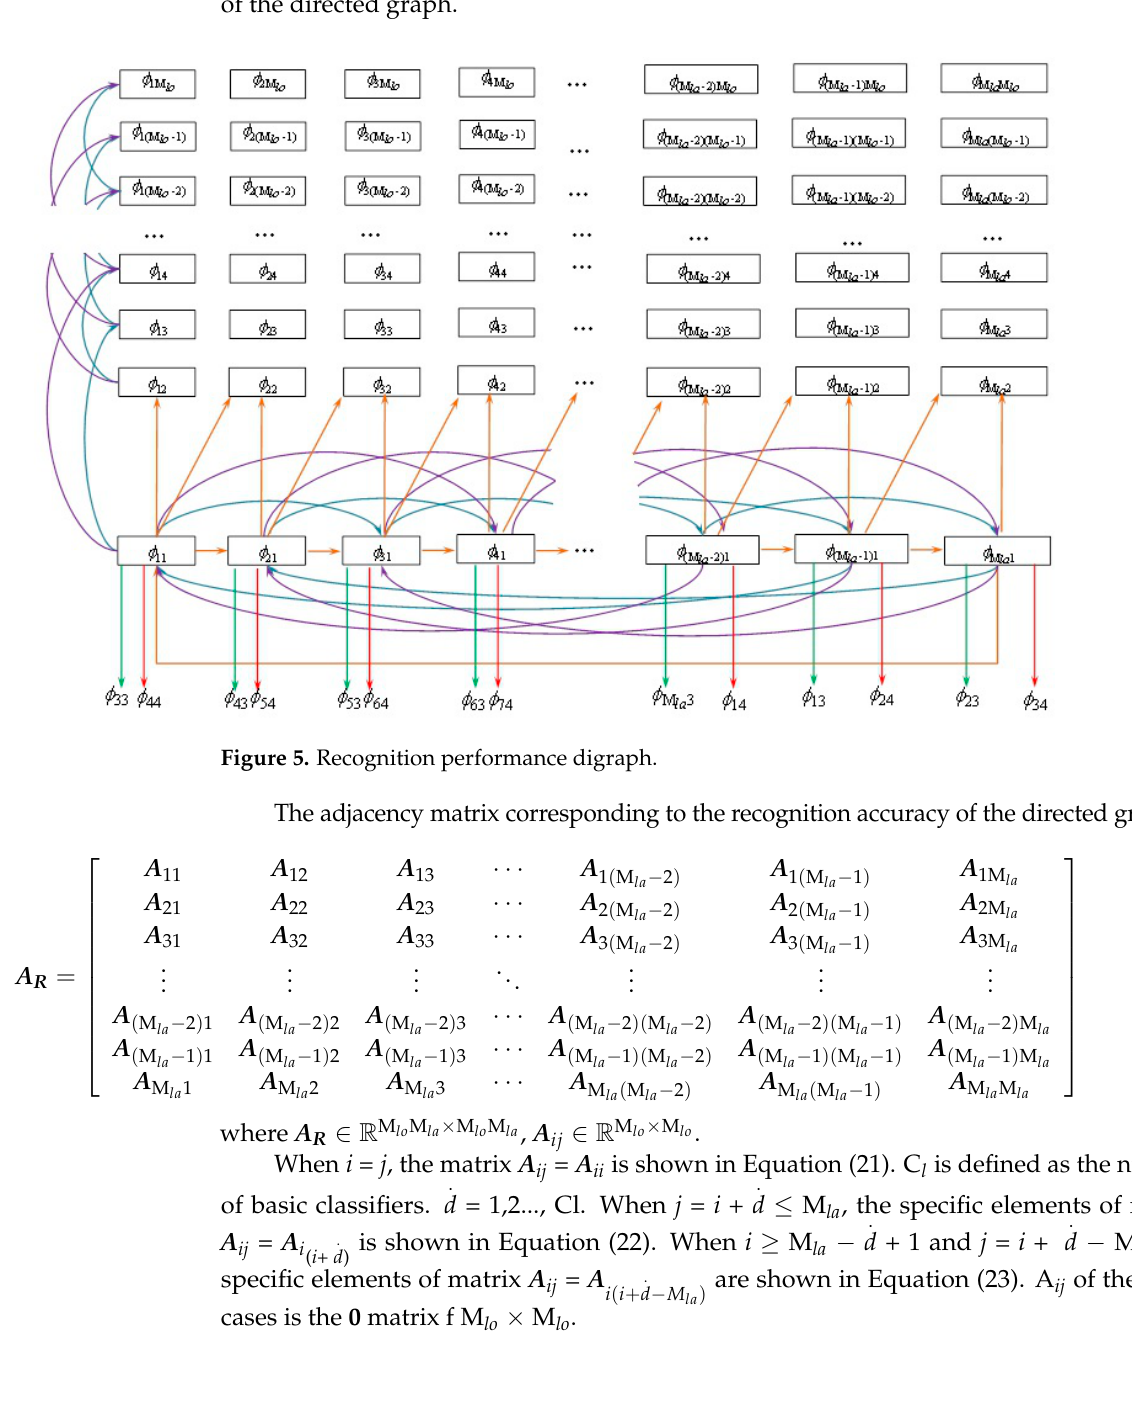
. d = 3, the green line represents the direction diagonally at . d = 3. The recognition rates of . d ( Φ ) are the edge weights ij , Φ ( i + d θ )( j + d λ )